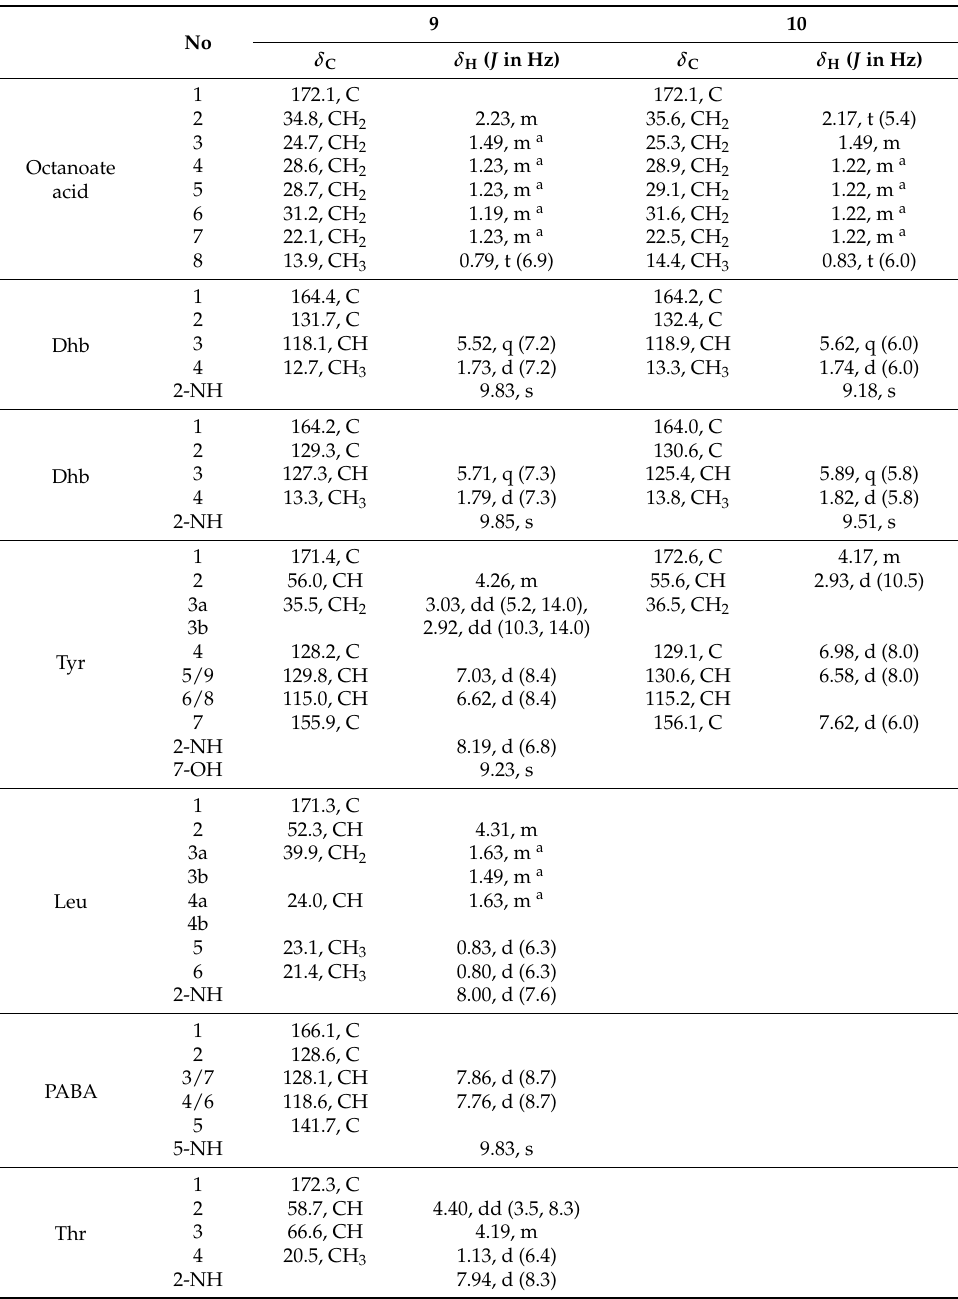
Haereogladiodins A ( 9 ) and B ( 10 ) were isolated as white solid and their molecular formulas were determined to be C 42 H 58 N 6 O 10 (HRESIMS, m/z 807.4272 [M + H] + , calcd 807.4287) and C 25 H 35 N 3 O 6 (HRESIMS, m/z 474.2600 [M + H] + , calcd 474.2599), respectively. The 1D NMR data of 9 and 10 (Table 5) were similar to haereoglumins A and B, but with the difference in the first amino acid [28], which showed a Tyr in 9 and 10 . Their structures were further confirmed by the 2D NMR correlations (Figure 4) and MS/MS fragmentations (Figure S8). The E -geometry of the double bonds in Dhb was determined by the NOESY correlations (Figure 4). According to Marfey’s analysis, the absolute configuration of the amino acids in 9 and 10 are D-Tyr, L-Leu, and L-Thr, respectively. Table 5. The 1 H (500 MHz) and 13 C NMR (125 MHz) data of 9 – 10 in DMSO- d 6. 9 10 No δ C δ H ( J in Hz) δ C δ H ( J in